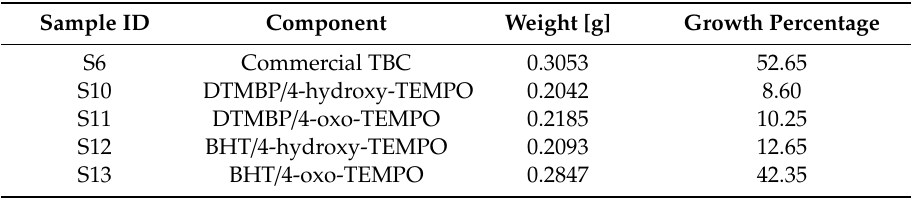
Table 5. Measured weights of polymer and the growth percentage in the presence of inhibitor blends after 4